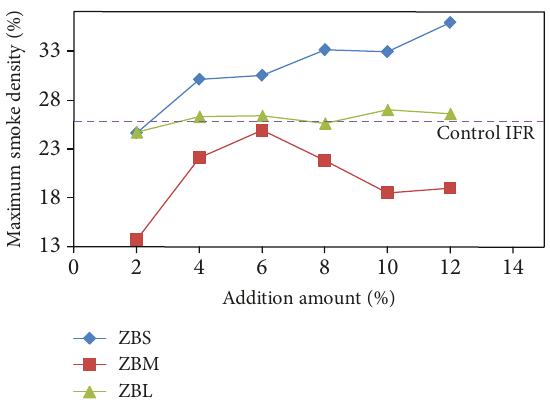
Figure 6: The maximum smoke density curve of wood treated with IFR/ZB coatings.